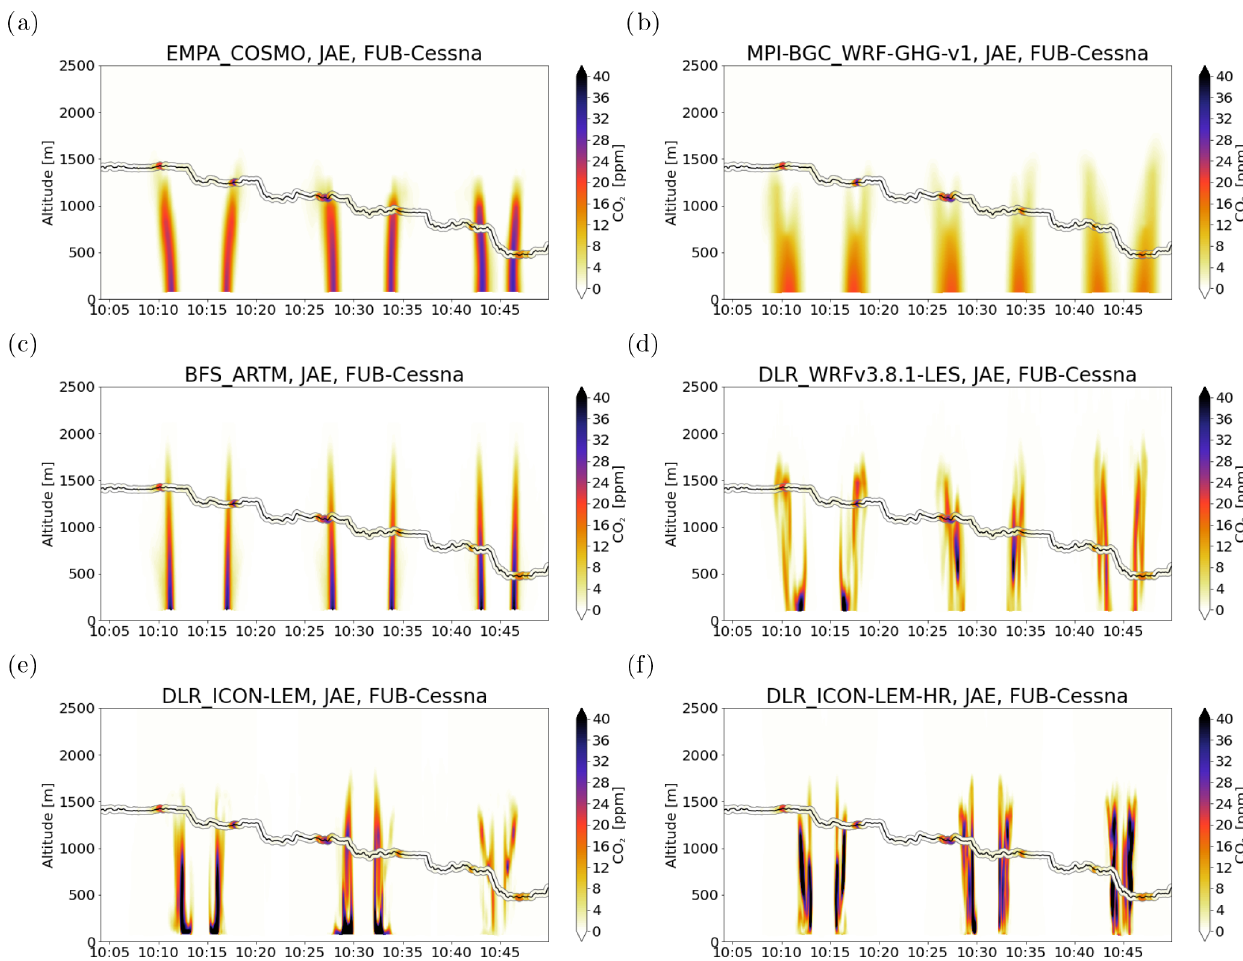
Figure 6. Curtains of the Jänschwalde CO 2 plume along the FUB Cessna flight on 23 May 2018. Figures show the middle release tracer